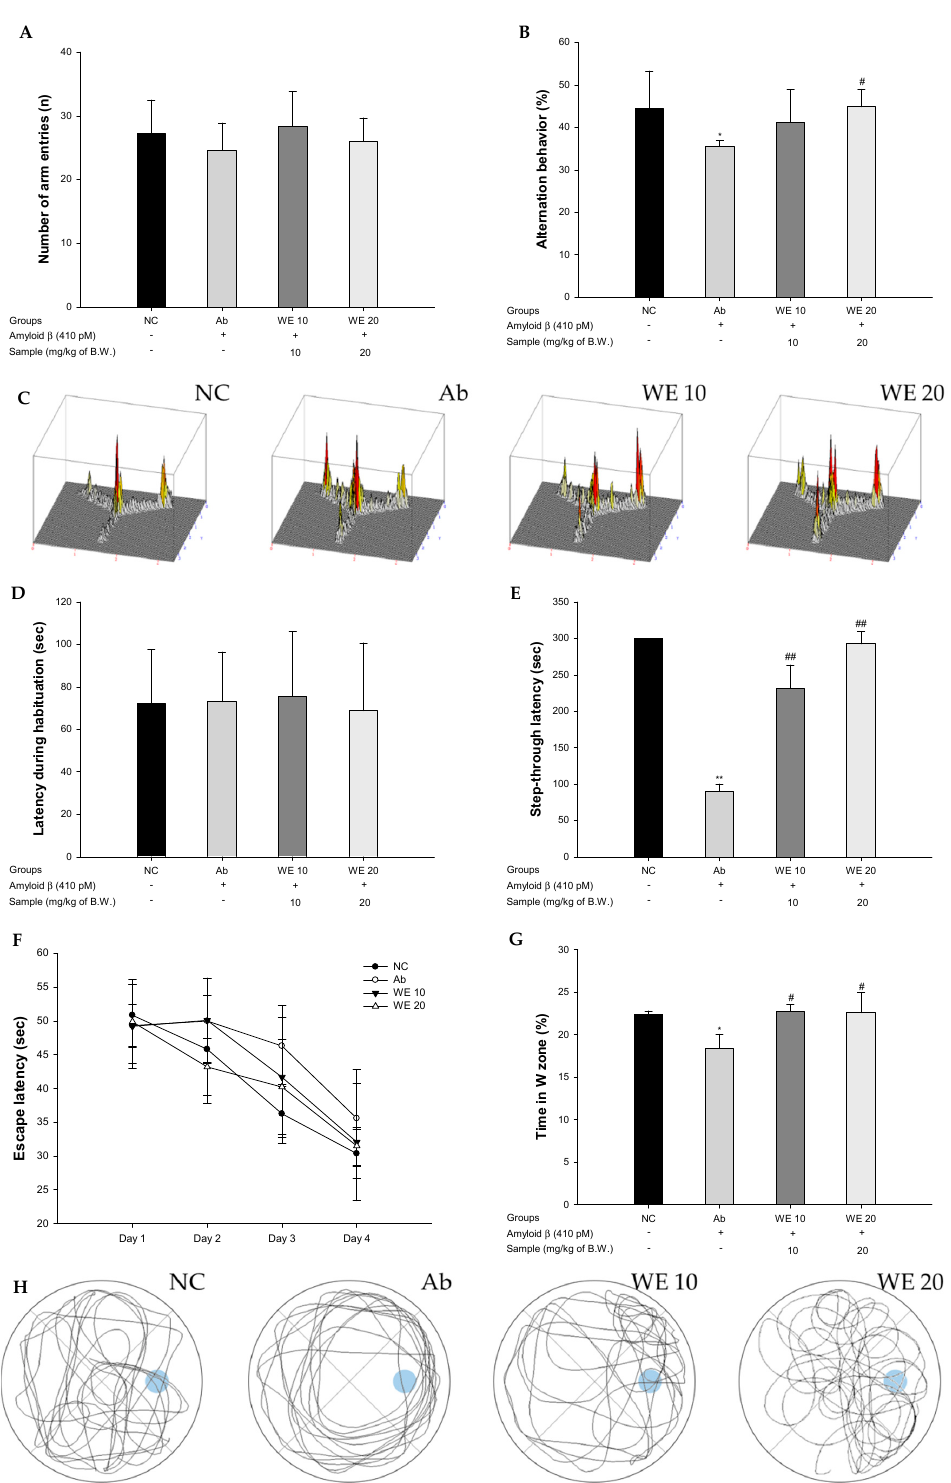
Figure 3. Protective effect of walnut ( Juglans regia L.) extract in A β -induced mice: ( A ) Spontaneous alternation behavior; ( B ) number of arm entries; ( C ) three-dimensional (3D) moving routes; ( D ) latency during habituation; ( E ) step-through latency; ( F ) escape latency in the training trial; ( G ) retention time on W zone in the probe trial; and ( H ) path tracing of each groups in the probe trial. Results shown are means ± SD ( n = 7). Data are statistically represented at * = significantly di ff erent from the NC group, and # = significantly di ff erent from Ab group; * and # p < 0.05, ** and ## p <